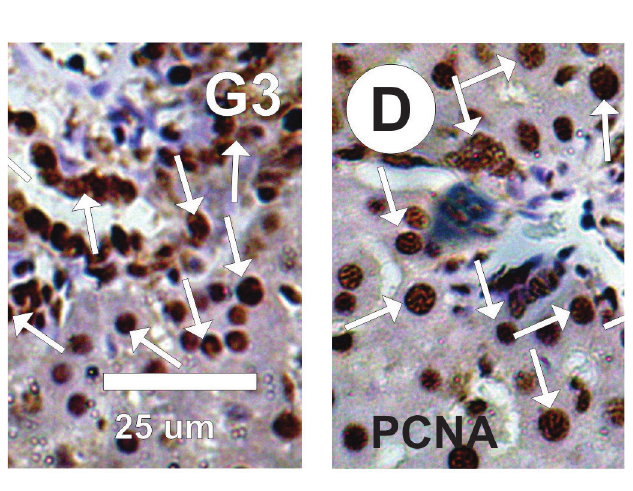
FIGURES 3(A -F) - Photomicrographs of liver sections stained with PCNA-ir in the different groups. A&B: Liver sections in control (G1) and costus (G2) groups in showed mild positive PCNA expression (arrows) in hepatocytes nuclei. C&D&F: Strong positive affinity for PCNA arrows) in the liver section in treated rats with Ethephon (G3) and with Ethephon self-healing (G5). E: Liver sections in the post-treated Ethephon with costus (G4) showed moderate positive expressions (arrows) for